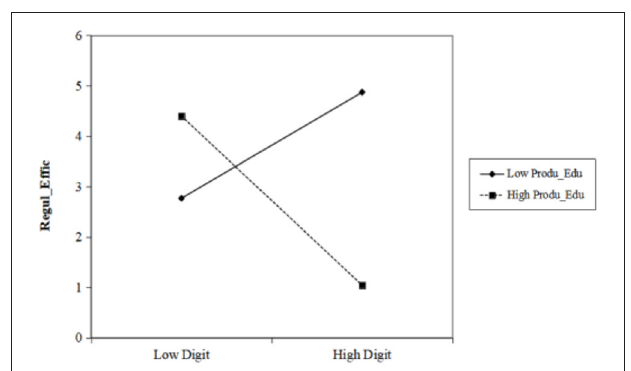
FIGURE 2 | Adjustment effect of producer knowledge